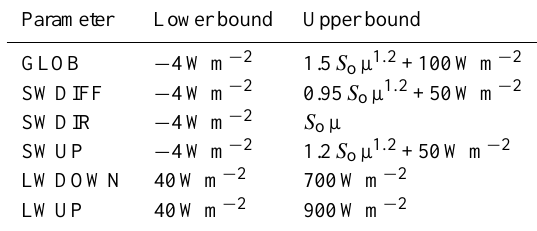
Table 1. This table shows the lower and up limits for the “Phys- ically possible” intervals used in flagging the radiation quantities. Values were flagged if outside the indicated interval. S o is the so- lar constant adjusted for Earth-Sun distance. µ is the cosine of the solar zenith angle. Parameters: GLOB: Global radiation, SWD- IFF: Diffuse shortwave radiation, SWDIR: Direct radiation, SWUP: Reflected shortwave radiation, LWDOWN: Downwelling longwave radiation, LWUP: Upwelling longwave